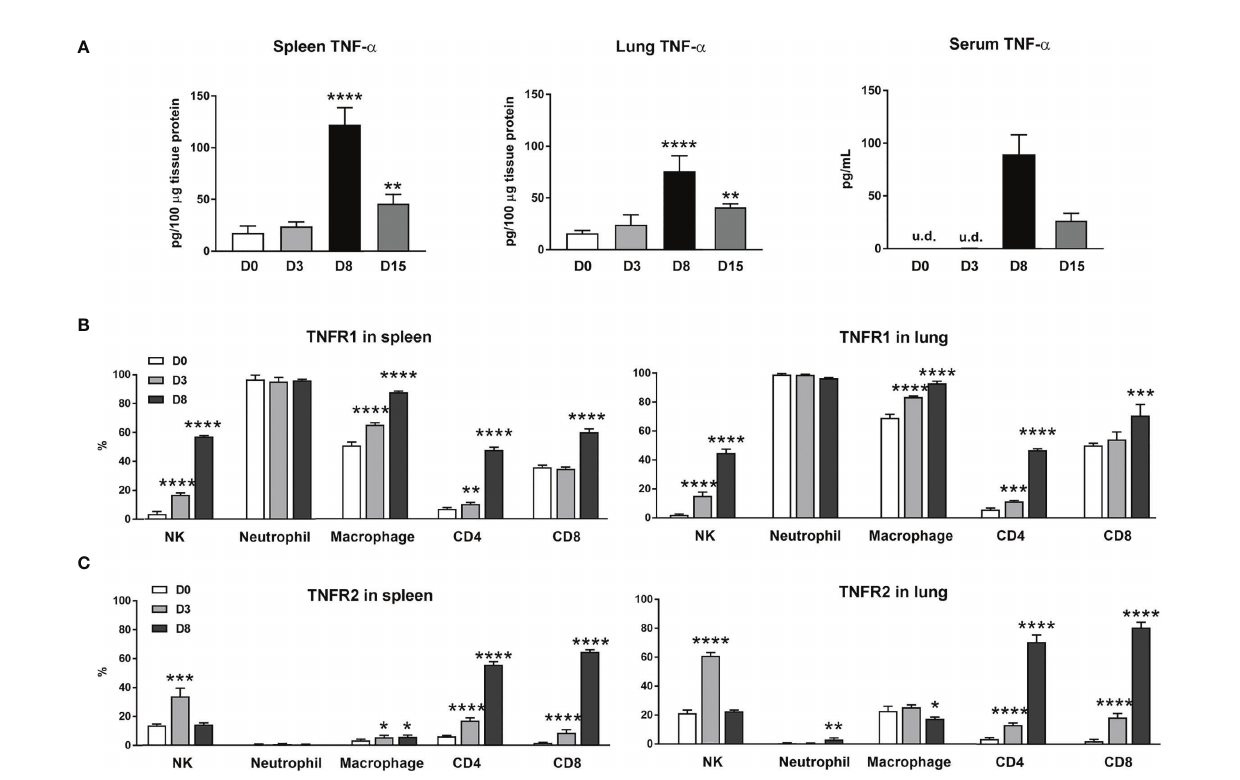
FIGURE 1 | Increased expression of TNF- a and its receptors during O. tsutsugamushi infection. B6 mice (5/group) were injected i.v. with 6 × 10 4 FFU of bacteria or PBS (used as a mock or D0). Spleen and lungs were collected for subsequent analysis at D3 and D8. (A) TNF- a protein levels in the spleen, lung and serum samples were analyzed by ELISA. (B, C) Surface TNFR1 and TNFR2 expression at D0, 3 and 8 on indicated immune cell subsets were analyzed by fl ow cytometry. Data are shown as mean ± SD from single experiments (n = 5) and are representative of two independent experiments. A one-way ANOVA with a Tukey ’ s multiple comparisons test was used for statistical analysis. * p <0.05; ** p <0.01; *** p < 0.001; **** p <